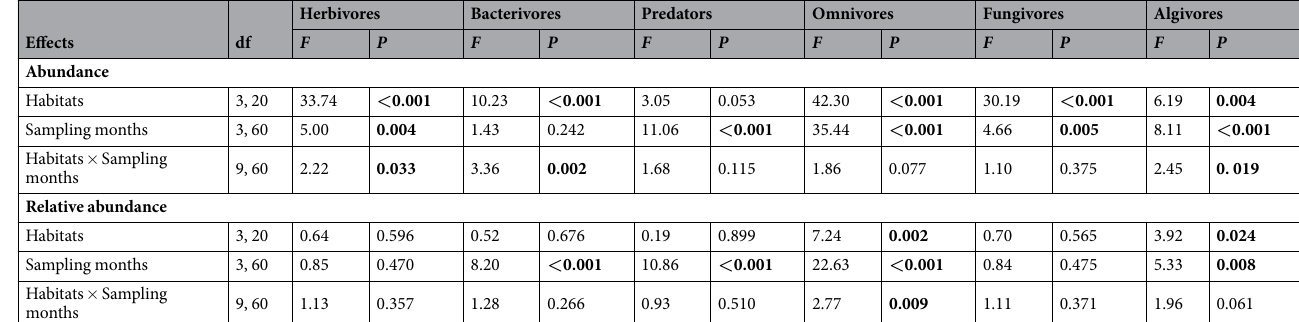
Table 4. Repeated-measures ANOVA results for the effects of habitats, sampling months and their interactions on the abundances and relative abundances of trophic groups of the soil nematode communities. The statistically significant ( P < 0.05) results are shown in boldface (n = 24).